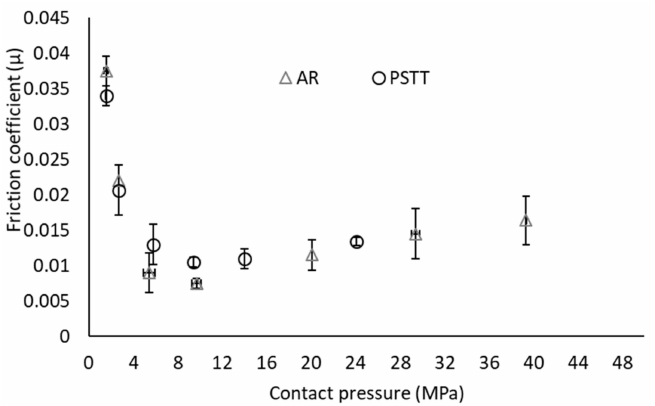
Figure 9. Evolution of the coe ffi cient of friction measured during the strip drawing test under di ff erent contact